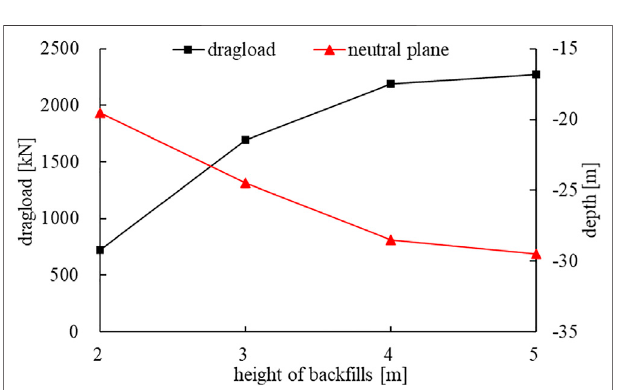
FIGURE9| Developmentofdragloadand neutralplanewithanincrease of the consolidation